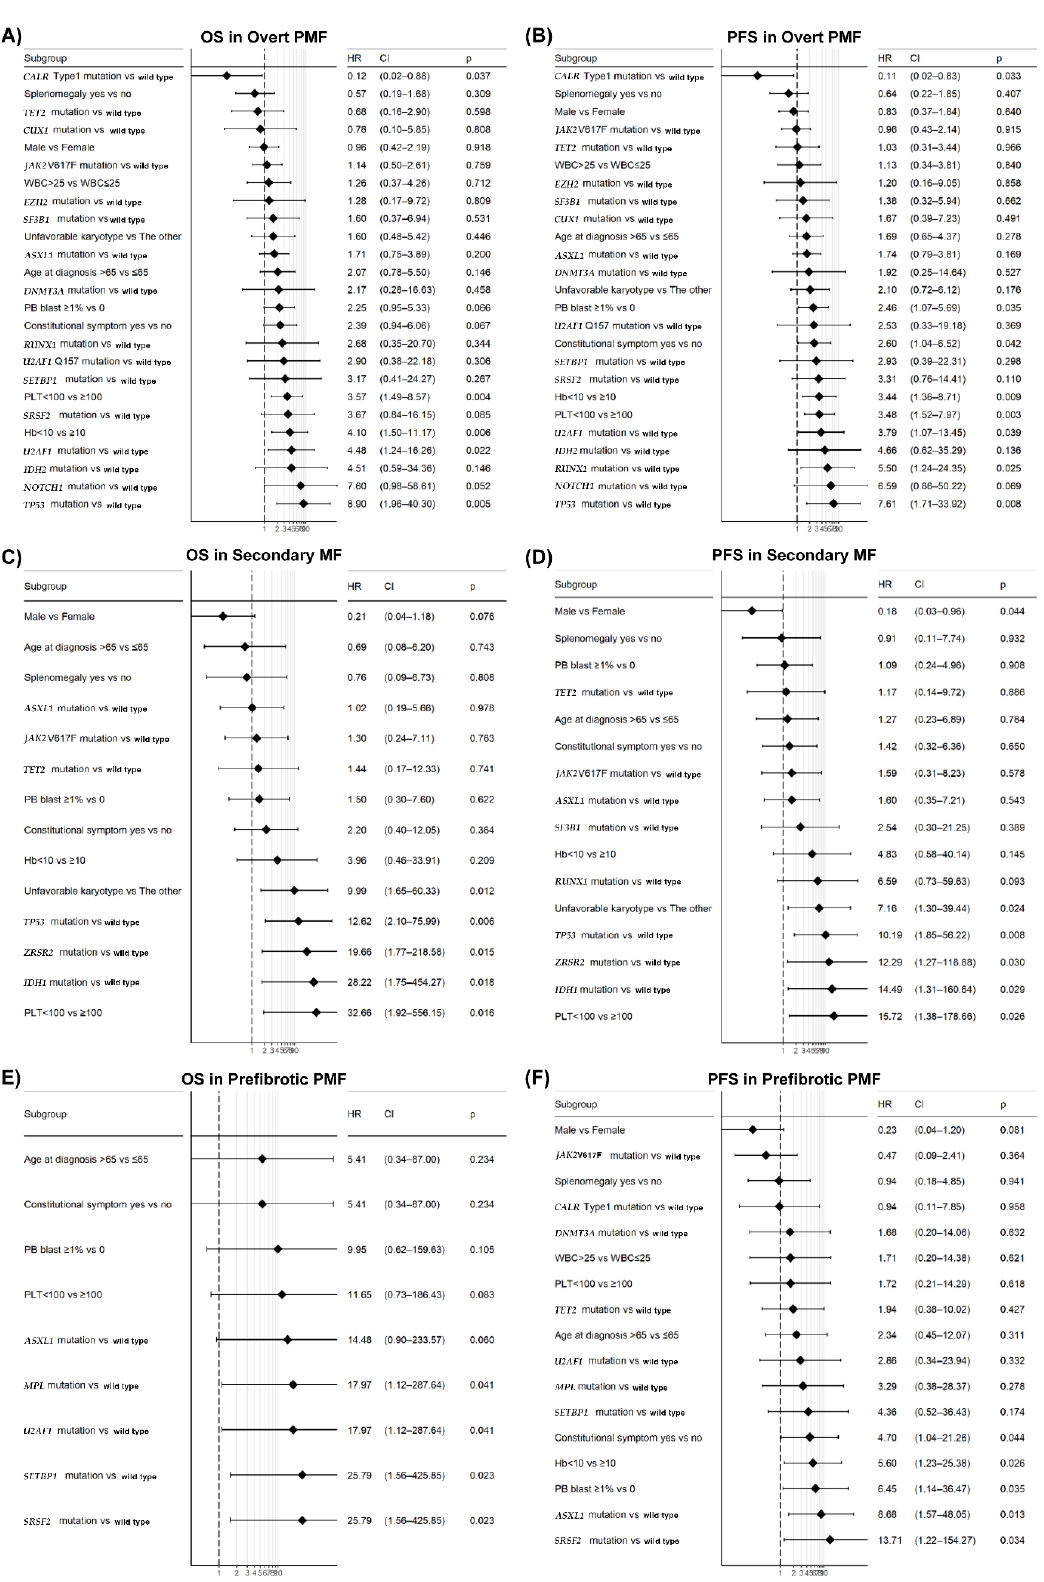
Figure 2. Univariate analysis of overall survival (OS) in the ( A ) primary myelofibrosis (PMF), ( C ) secondary myelofibrosis (SMF), and ( E ) prefibrotic myelofibrosis (pre-PMF) groups. Progression- free survival (PFS) in the ( B ) PMF, ( D ) SMF, and ( F ) pre-PMF groups.